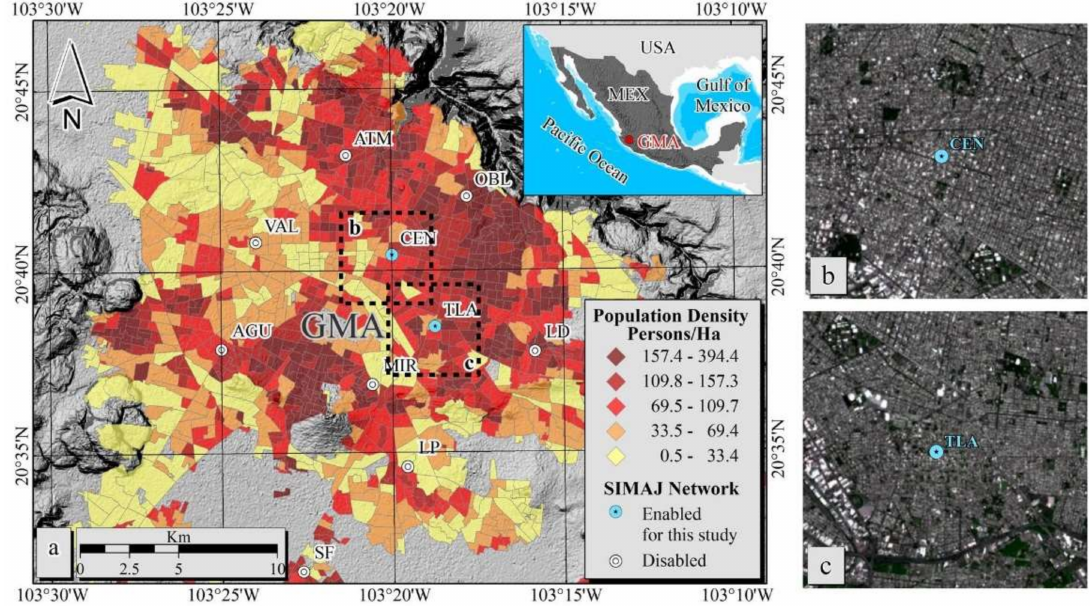
Figure 1. ( a ) Map of population density and monitoring sites located in Guadalajara metropolitan area (GMA). Blue circles show sampling sites location. ( b ) The Centro (CEN) and ( c ) Tlaquepaque (TLA) monitoring sites in the local